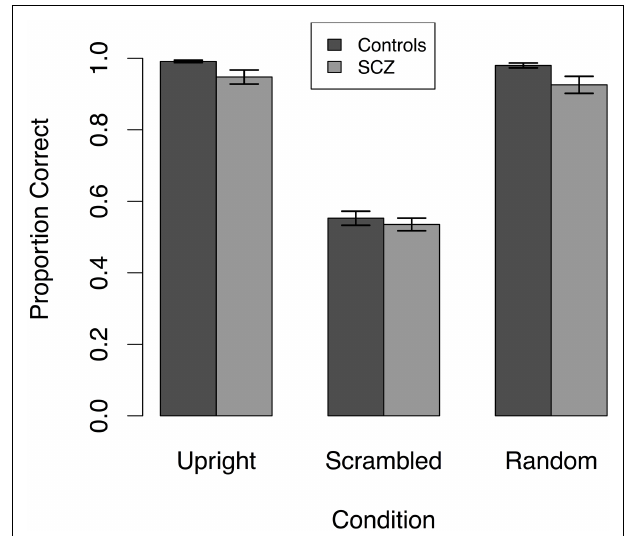
in a total of 240 trials. The dependent variable was the proportion of correct responses.